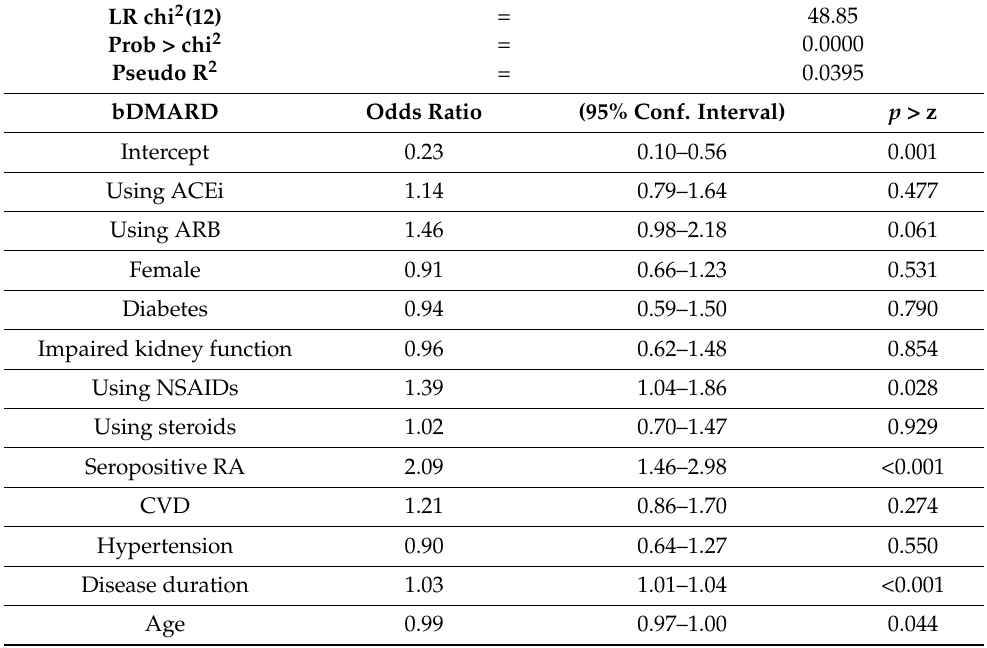
Table 4. Logistical regression of multiple confounders on the defined daily dose of bDMARDs, standard